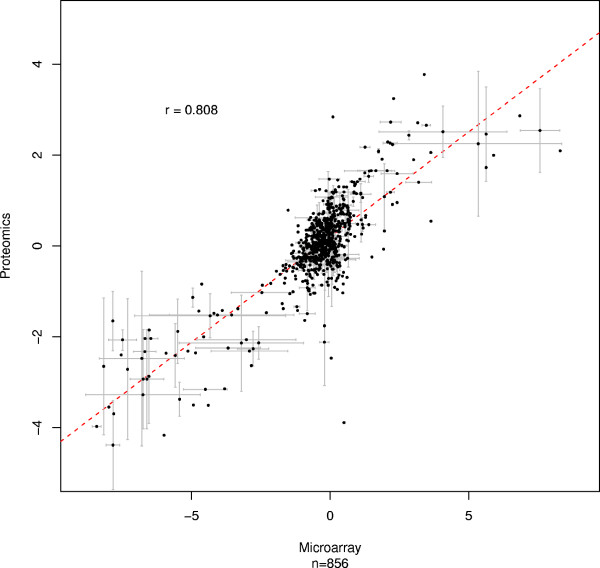
High correspondence between exon array and quantitative peptide data. Each point corresponds to an exon matched by at least one peptide and at least one array probeset. X and Y axes: fold-changes between MCF7 and MCF10A for the microarray probeset and quantitative peptide data, respectively. When more than one matching peptide/probeset was found, the mean value was calculated. Error bars represent one standard deviation. r: Pearson correlation. n: number of data points.